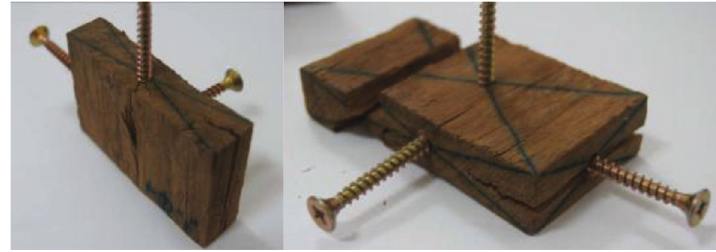
Figure 3: Damaged specimens when made for the nail-holding power testing. Table 1: Results of bamboo scrimber ’ s mechanical properties after the six-cycle accelerated ageing treatment ( mean ± standard deviation ). Nail-holding power (N) Cycle Horizontal shear strength (MPa) MOR (MPa) MOE (MPa)